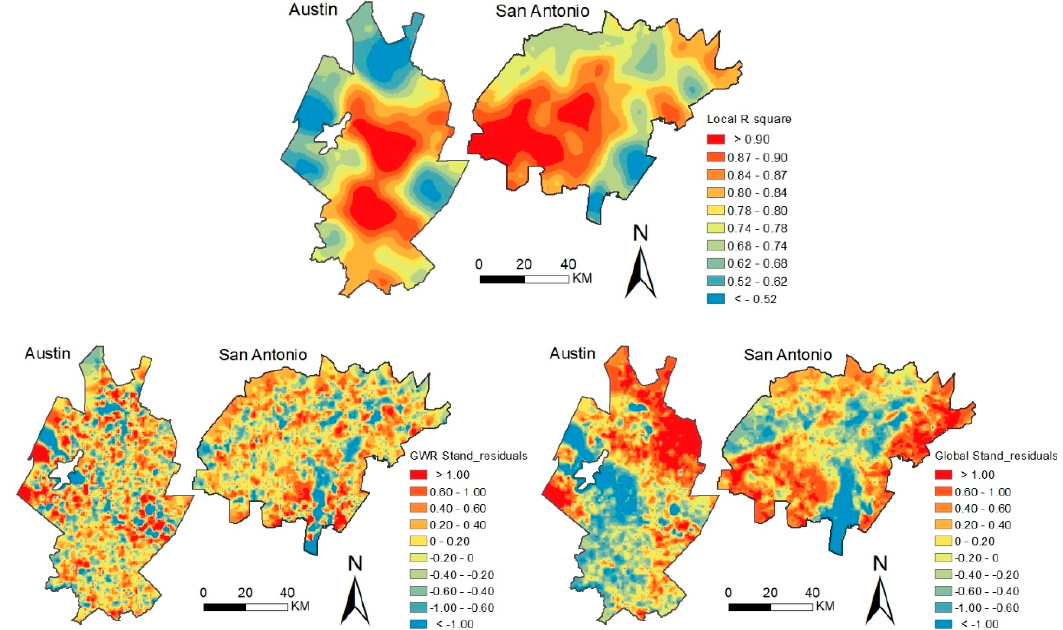
Figure 8. Overall spatial distribution of local R 2 values ( top ), standardized residuals of the GWR ( bottom left ), and global regression ( bottom right ) as measures of model goodness-of-fit.